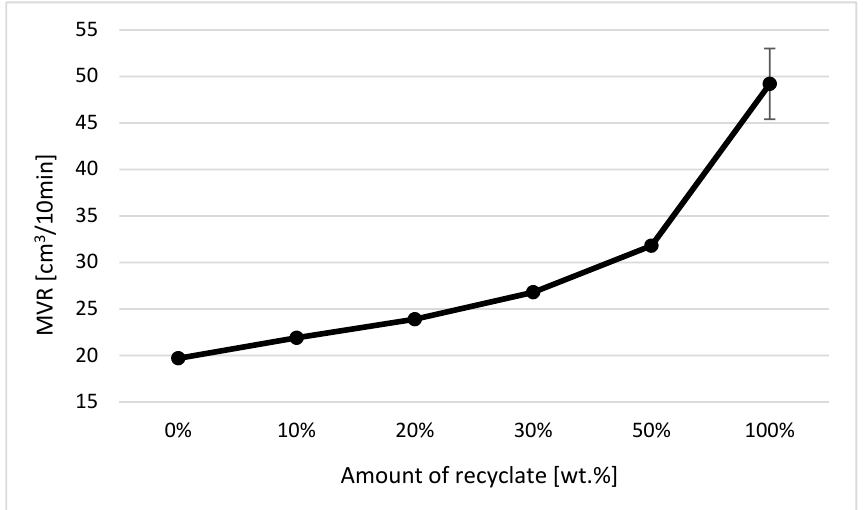
Figure 9. Dependence of the melt flow volume index on the proportion of weight of the recycled material prior to exposure.